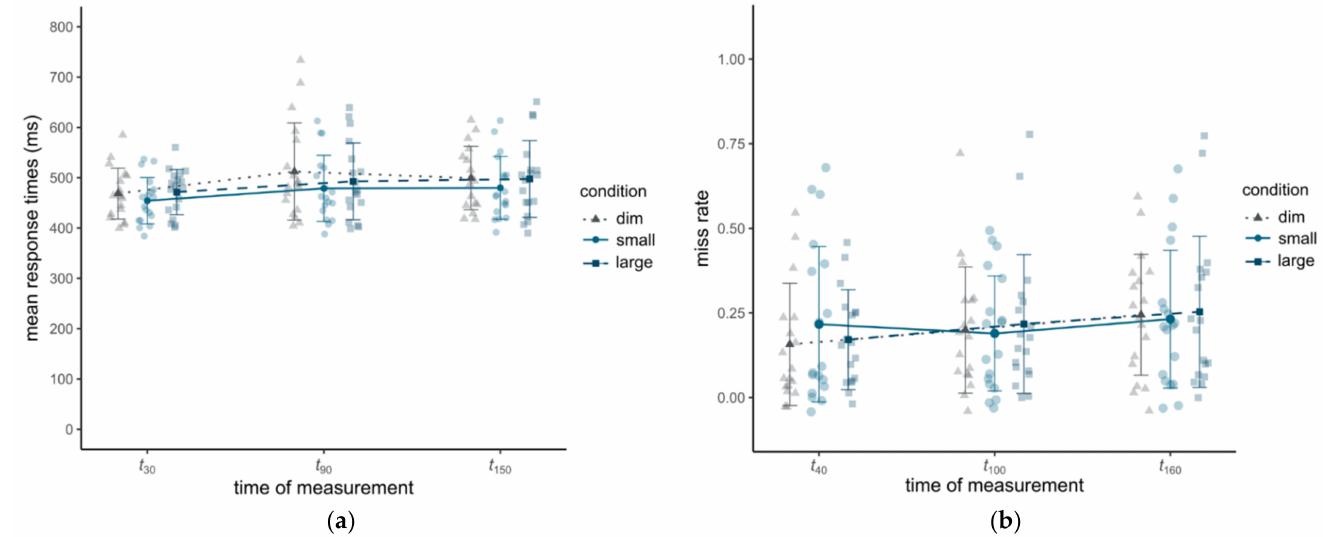
Figure 5. Mean values of reaction times in the PVT ( a ) and miss rates in the MWCT ( b ) for each time of measurement and experimental condition. The error bars represent the standard deviations. The individual mean values are pale